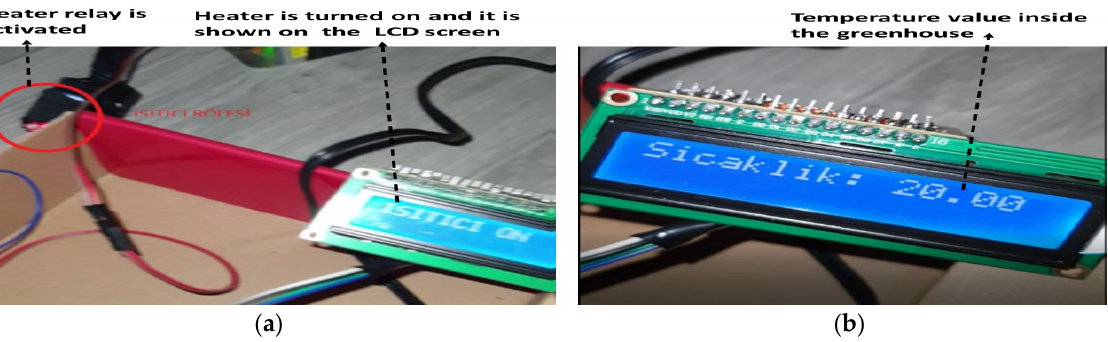
Figure 8. ( a ) Activation of the heater relay and ( b ) display of the temperature on the LCD screen.